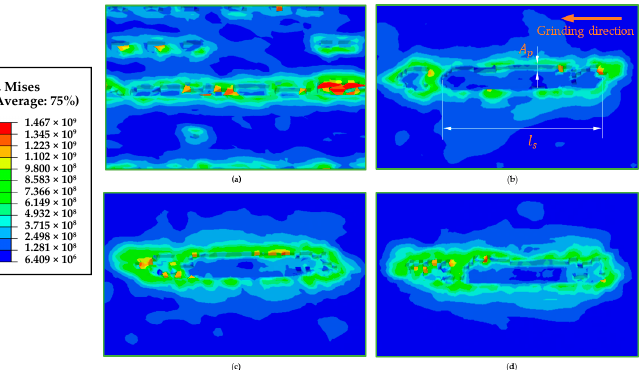
Figure 5. Simulated micro-pit of group 1: ( a ) A = 0, ( b ) A = 8 µm, ( c ) A = 10 µm, and ( d ) A = 12 µm.